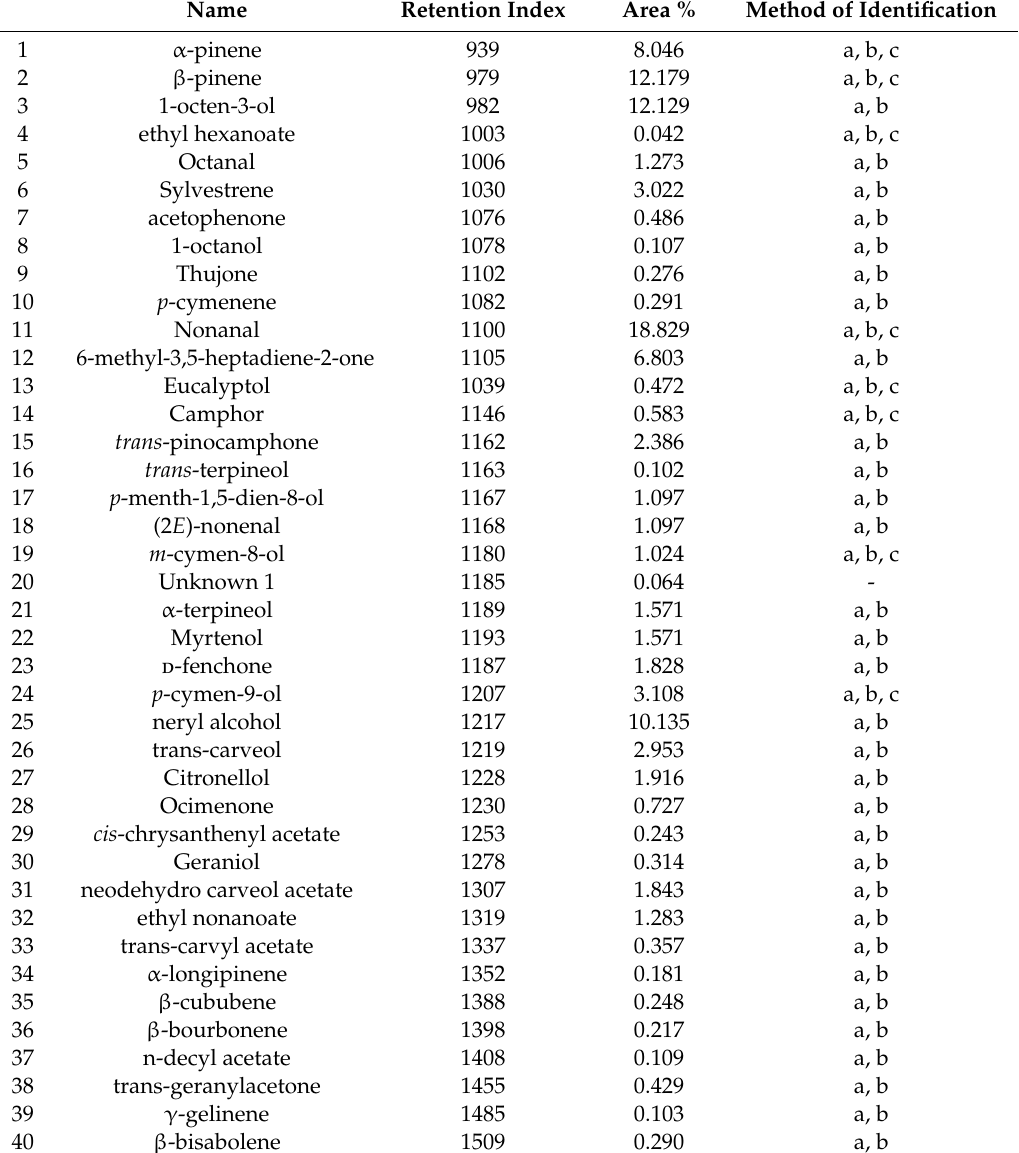
Table 5. Volatile components from Mexican propolis GUA-4.